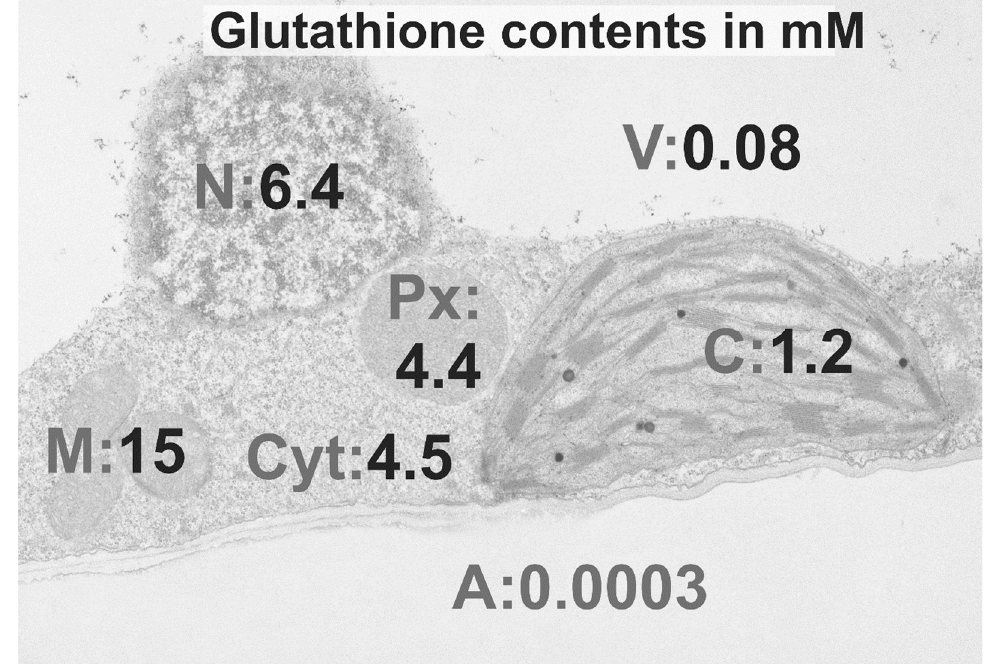
Figure 2. Compartment-specific concentrations of glutathione in non-stressed Arabidopsis Col-0 plants. Transmission electron micrograph of a leaf cell with overlay of compartment-specific concentrations of glutathione for chloroplasts (C), the cytosol (Cyt), mitochondria (M), nuclei (N), peroxisomes (Px), and the vacuoles (V). Glutathione contents were determined by using a combination of biochemical measurements and cytohistochemical detection of glutathione by transmission electron microscopy [60] . As glutathione could not be detected in the apoplast (A) with cytohistochemical methods, concentrations in the apoplast were taken from a study where glutathione concentrations were measured with biochemical methods after extraction of soluble apoplastic glutathione [45] .